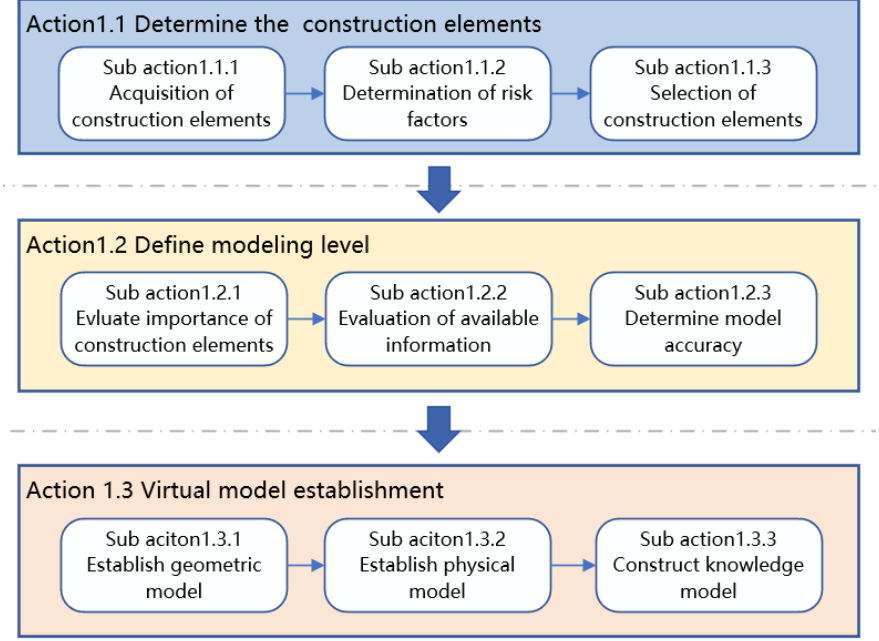
Figure 3. Actions and sub-actions of phase 1.